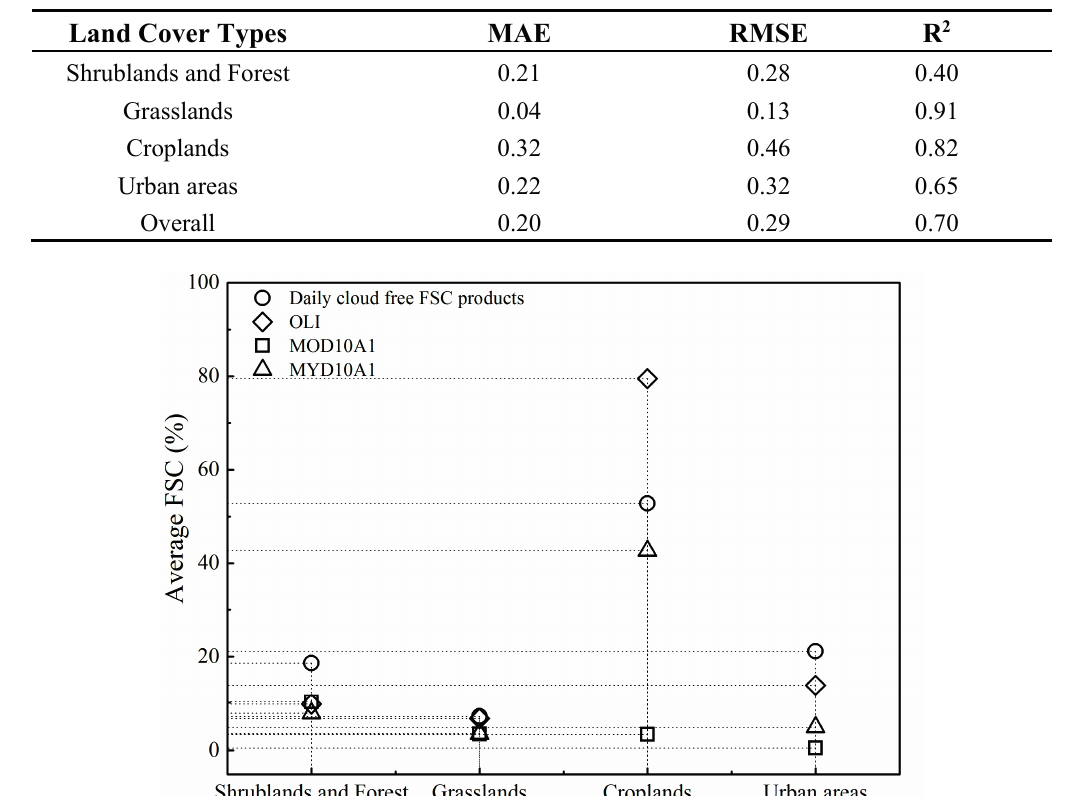
Figure 8. The mean FSCs of the MOD10A1, MYD10A1 and OLI image and the daily cloud-free FSC mapping for different land cover types in the text area during November 2013 to February